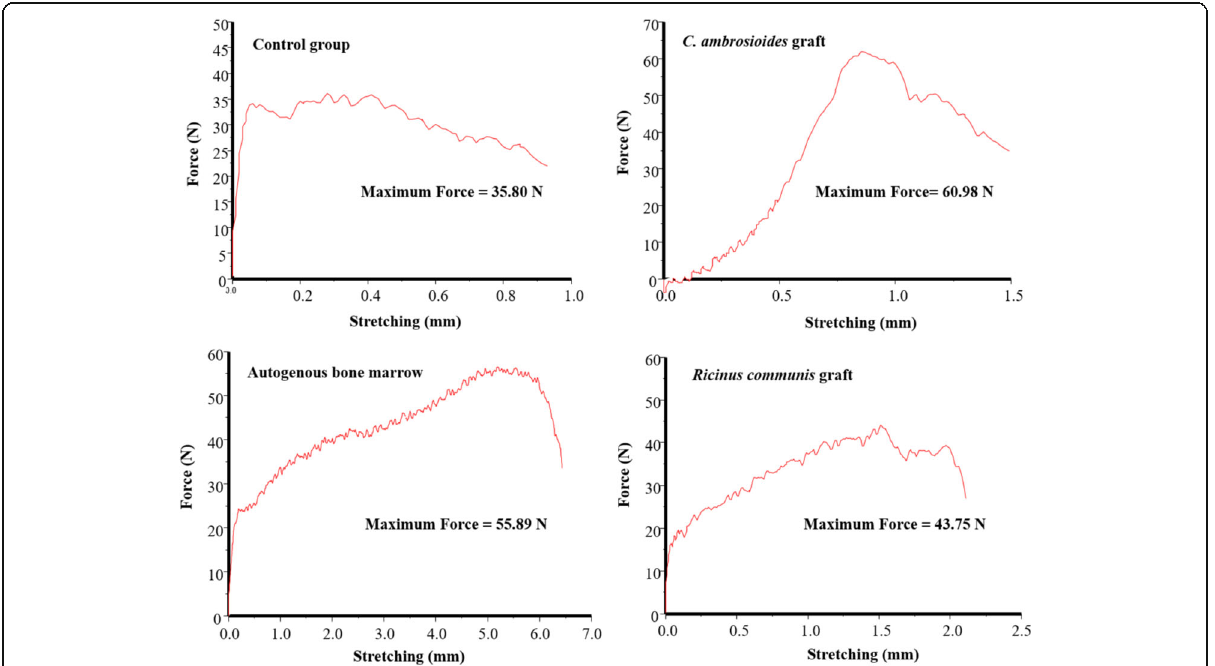
Fig. 4 Effect of a graft of lyophilized aqueous Chenopodium ambrosioides L. extract on bone formation. Biomechanical analysis at 60 days. The results are reported as maximum force (Fmax). Groups: Control group, C. ambrosioides graft, Autogenous bone marrow e Ricinus communis